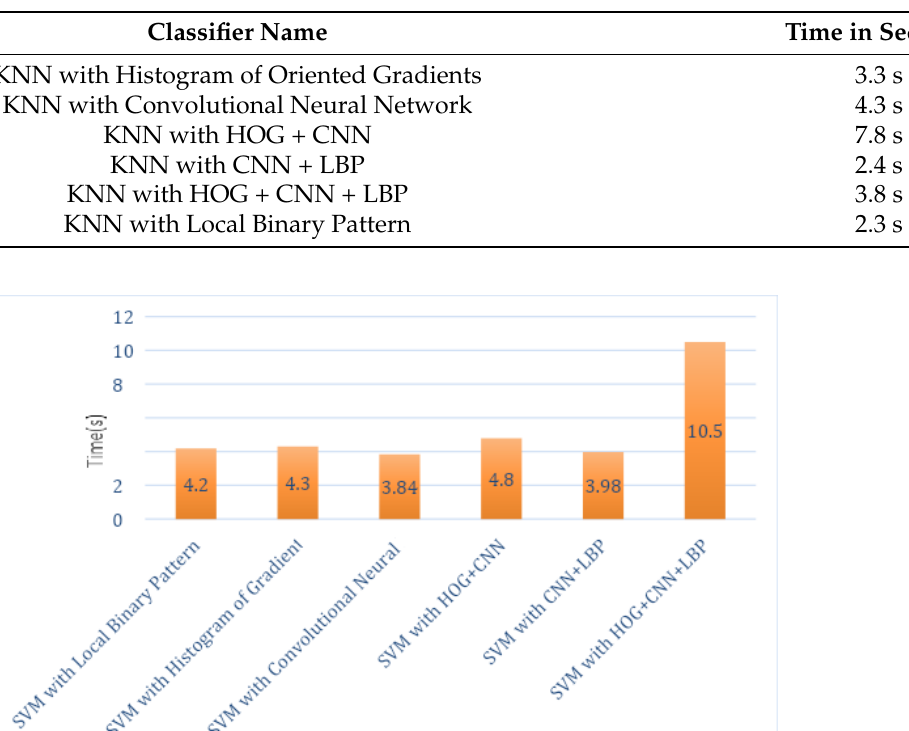
Table 4. Execution Time by KNN Classifier Using LBP, CNN, and HOG.